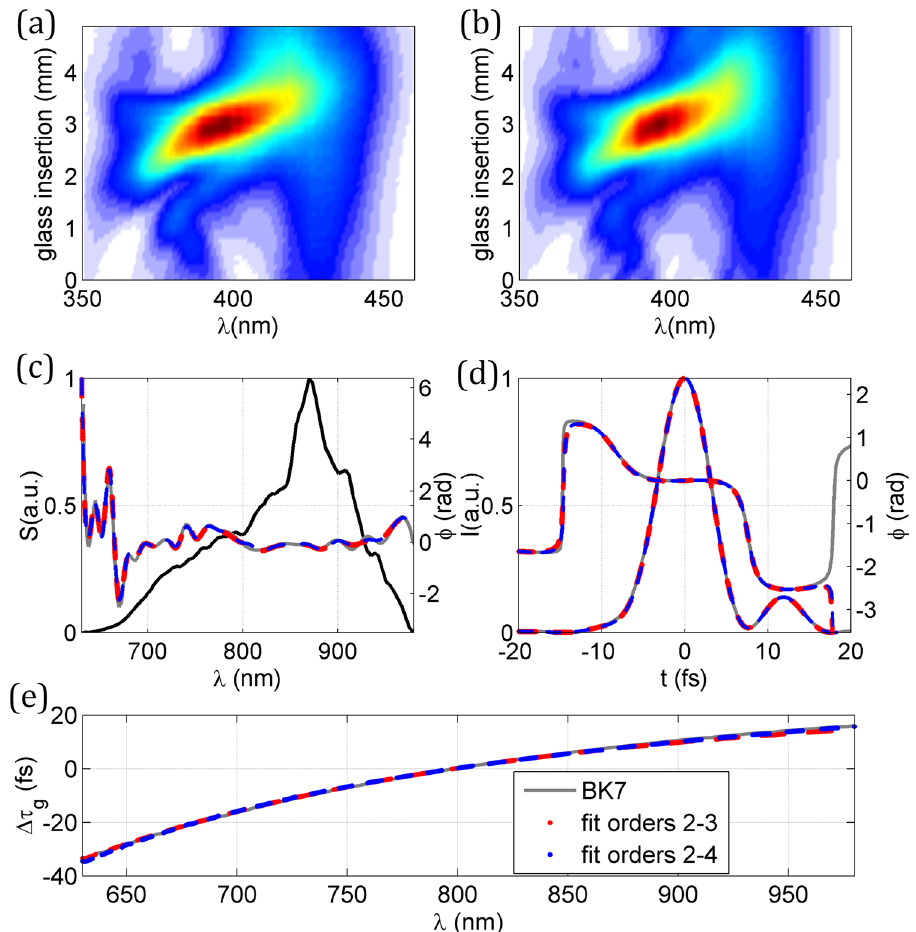
Figure 3. Results of the self-calibrating d-scan of the few-cycle laser oscillator. ( a ) Experimental and ( b ) retrieved d-scan trace using the self-calibrating d-scan algorithm with glass dispersion fitted up to 3 rd order. ( c ) Spectral intensity and retrieved phase, ( d ) retrieved temporal intensity and phase. In ( c ) and ( d ): using the known BK7 dispersion and the standard d-scan algorithm (solid grey curve); using self-calibrating d-scan with dispersion fit to orders 2–3 (dashed red curve) and orders 2–4 (dashed blue curve). ( e ) Comparison of the variation of the group delay per mm calculated for BK7 (solid grey) and obtained from self-calibrating d-scan using dispersion fit to orders 2–3 (dashed red) and orders 2–4 (dashed blue).